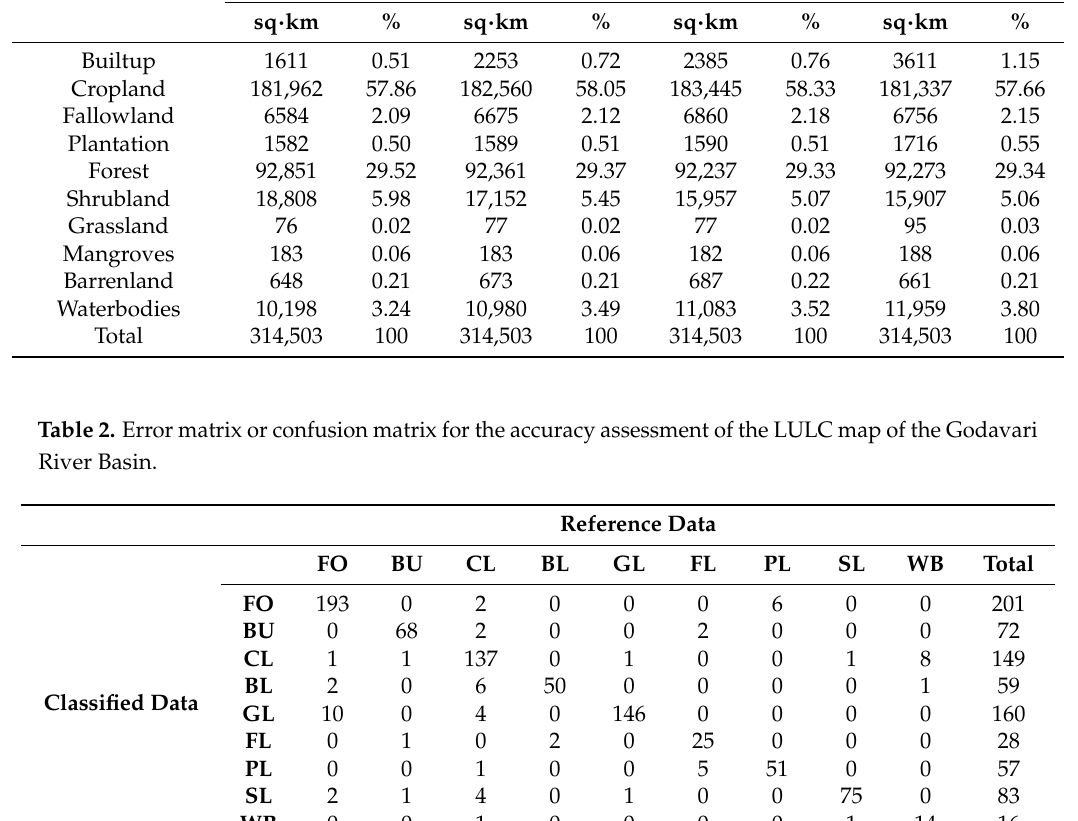
Figure 4. Land use/land cover (LULC) map of the Godavari basin of the years ( a ) 1985; ( b ) 1995; ( c ) 2005 and ( d ) 2014. Table 1. Table showing the various land-use/land-cover (LULC) categories of the Godavari River Basin. LULC Class